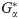
The time course of membrane Gα* (left) and Ric8* (right) at the front half and
rear half in the cAMP gradient used in Fig 7.